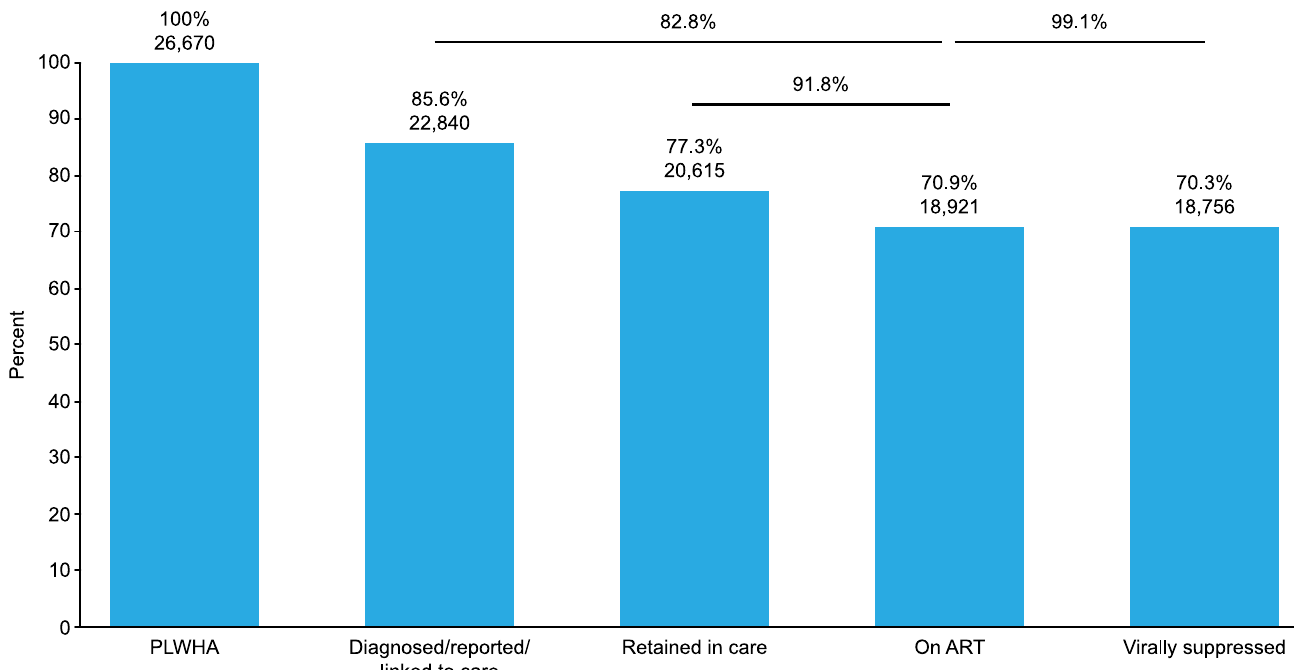
Fig 2. HIV care cascade in Japan. Columns in blue and the numbers and percentages abovethem show the care cascade using the number of PLWHA (26,670)as the denominator. The lines and percentages above them show the cascade calculatedbetween the columns indicatedby the lines.